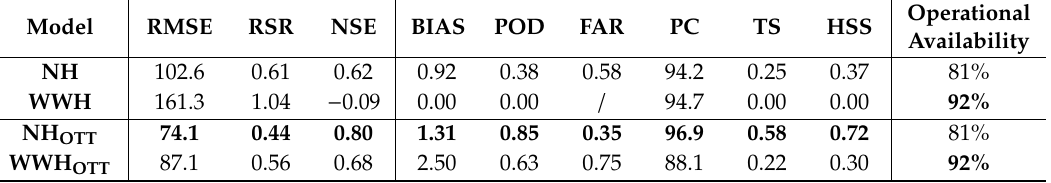
Figure A2. Hydrograph of original and optimized 5-day forecasts from NH and WWH in Bossey Bangou for the wet season of the validation year (1 June 19–31 Octomber 19). Continuous and categorical indices and operational availability in Garbey Kourou (Table A2) and Bossey Bangou (Table A3) hydrometers. Table A2. Continuous and categorical indices and operational availability for original and optimized forecasts at Garbey Kourou. Best performance is shown in bold.